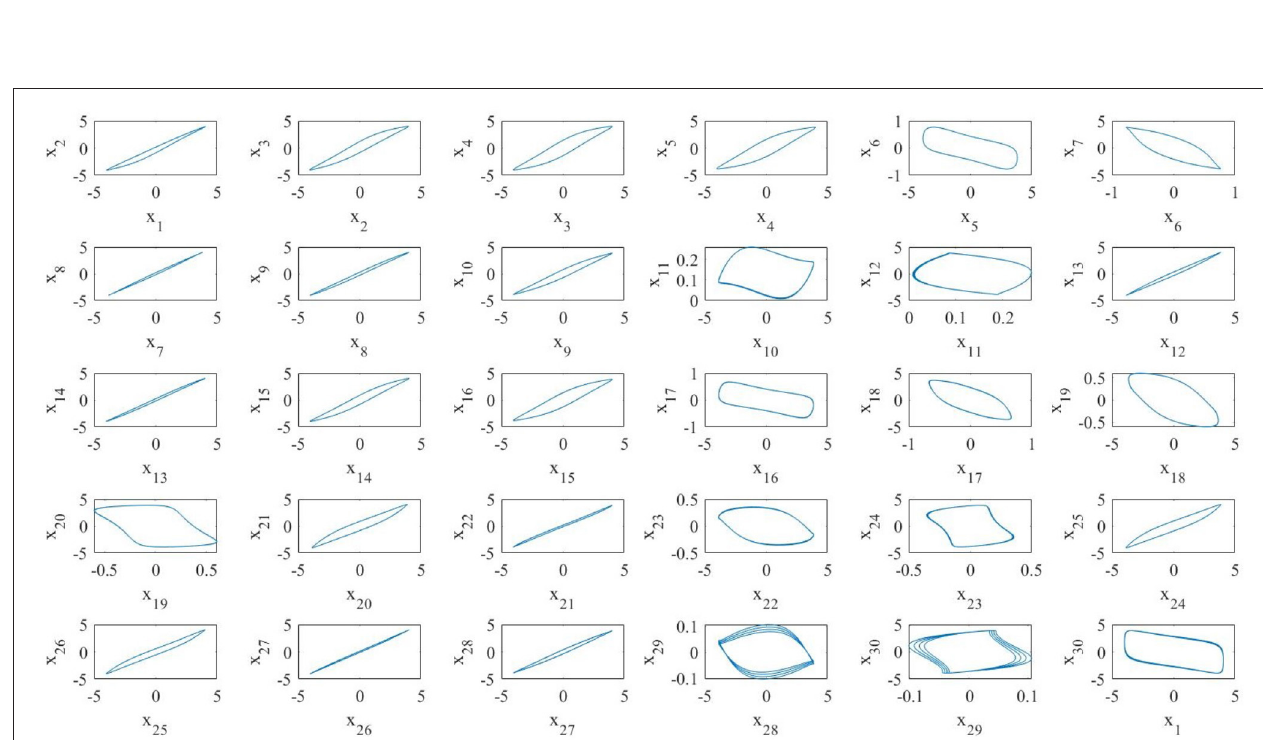
FIGURE 7 | Phase portraits in the case of a diffusive array of N = 30 MOCs. Only some oscillators are synchronized.